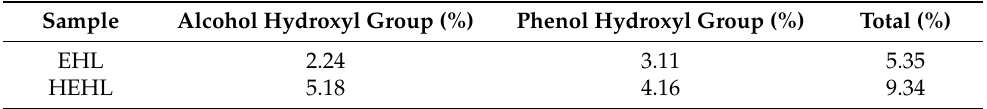
Table 3. Hydroxyl content of EHL and HEHL.